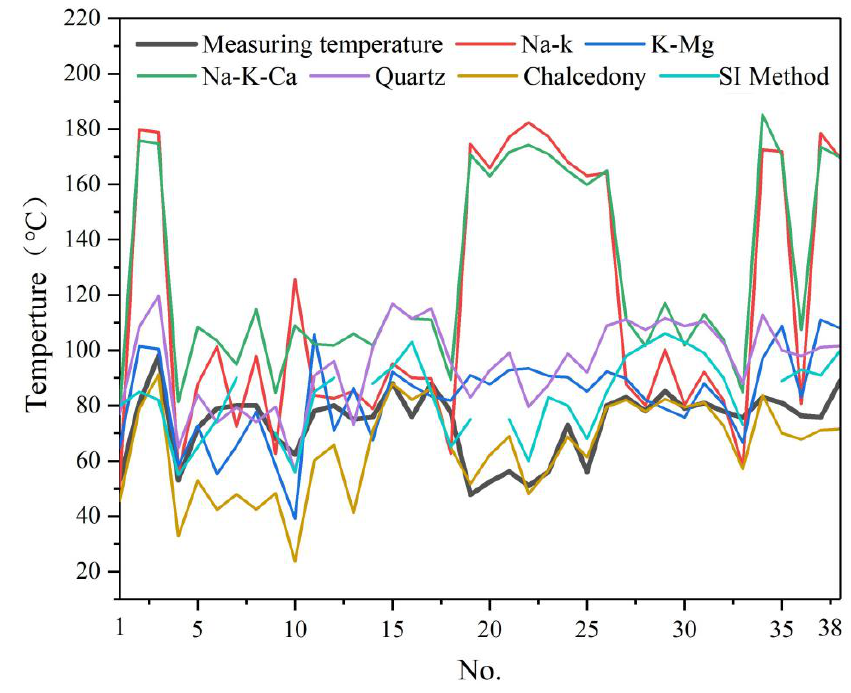
Figure 7. Comparison of measured and estimated temperatures.